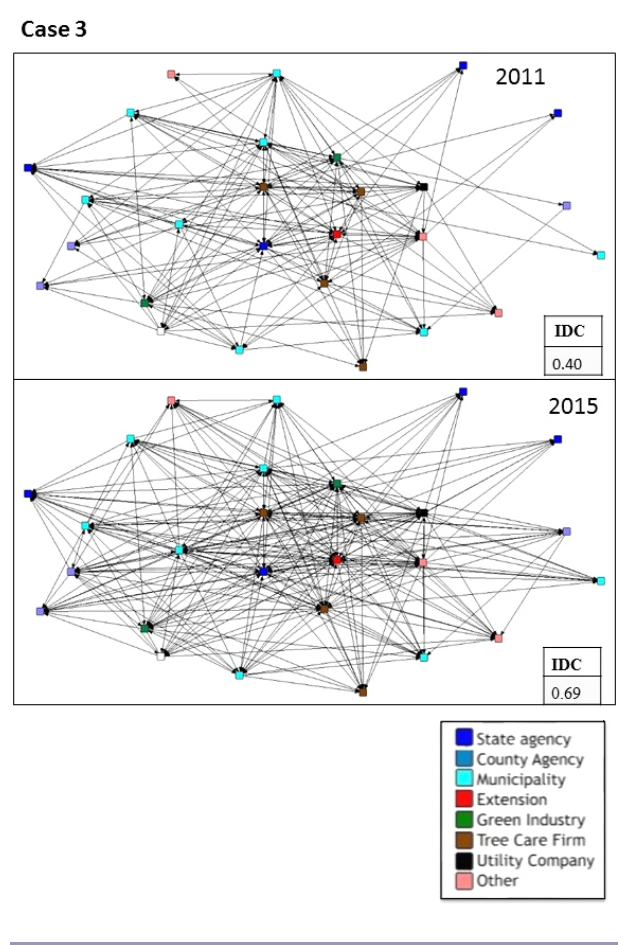
Fig. 3 . Changes in degree centrality (IDC), normalized to group size and network map of emerald ash borer (EAB) task force, Case 3. Note: IDC value refers to mean in-degree